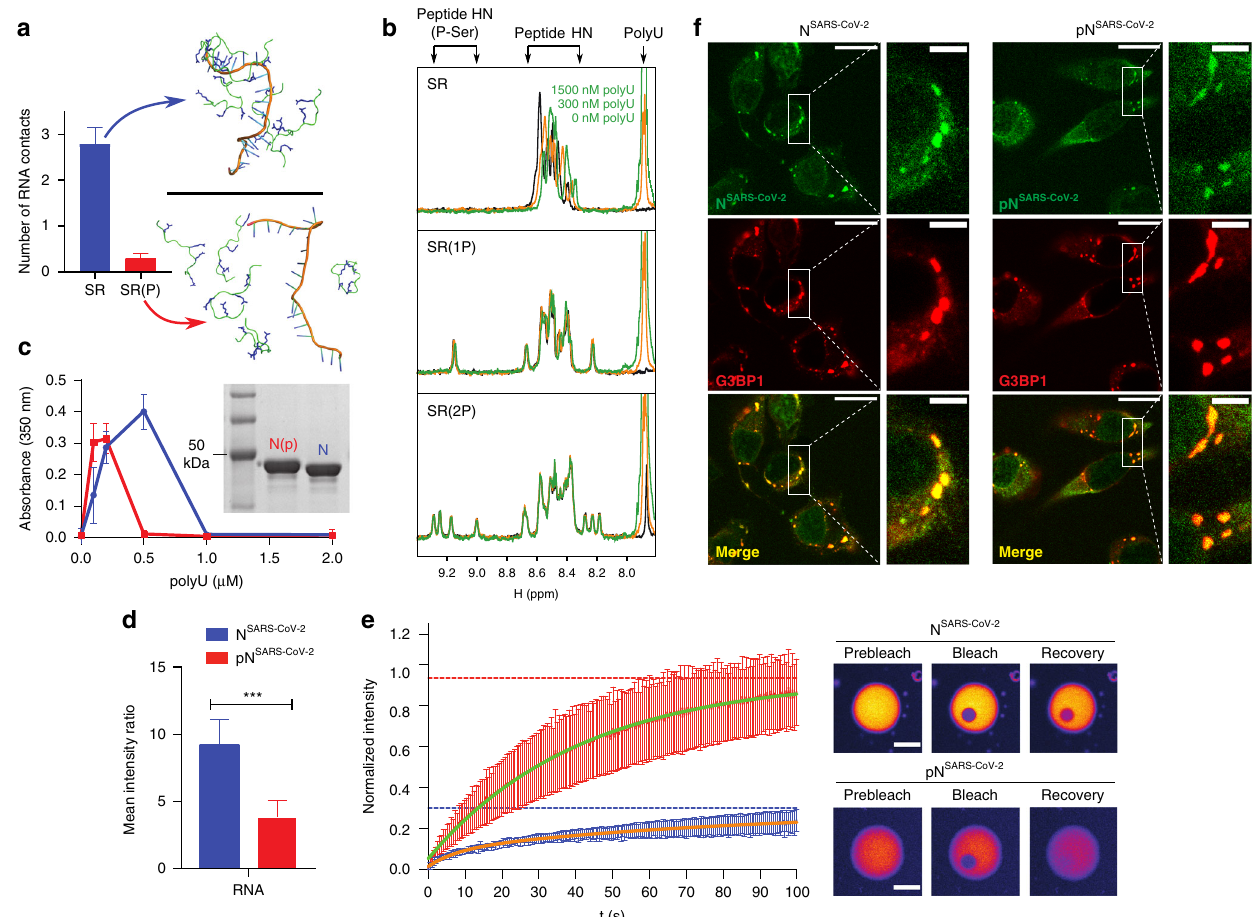
Fig. 4 SR-phosphorylation modulates RNA-induced condensation of the nucleocapsid protein. a MD simulations of SR/polyU-interaction. The number of contacts per peptide with a 20 base length polyU is shown in the top graph for the non-phosphorylated and fully phosphorylated SR-peptide as the average and standard deviation of fi ve independent simulations. Snapshots of both peptides are shown. b 1 H 1D experiments of the SR-peptide (1766.8Da), SPRK1 single-phosphorylated peptide (SR(1 P); 1846.9 Da according to mass spectrometry) and SPRK1 double-phosphorylated peptide (SR(2 P); 1926.9 Da according to mass spectrometry; Supplementary Fig. 8) at three different concentrations of polyU (0, 300 and 1500 nM). The spectral regions, in which the signals of polyU, the backbone H N s of unmodi fi ed residues and phosphorylated serines are located, are marked. The positive charges of the SR-peptide are compensated by the polyU negative charges at around 300 nM. c Turbidity at 350 nm of solutions of non-phosphorylated (blue) and SRPK1- phosphorylated (red) N SARS-CoV-2 in 20 mM NaPi, pH 7.5, at 30 µ M protein concentration and increasing concentrations of polyU. Average values from three independent measurements are shown. Error bars, std. An SDS-Page gel (insert) displays a band shift due to SRPK1-phosphorylation. d Decreased RNA recruitment into polyU-induced droplets of N SARS-CoV-2 upon phosphorylation with SRPK1 kinase. Mean values and standard deviation are displayed (n = 100 droplets). Two-sided t test with P value set to < 0.05 for statistical signi fi cance, *** < 0.001, ** < 0.002 and * < 0.033, ns < 0.12. e FRAP of N SARS-CoV-2 (blue) and SRPK1-phosphorylated N SARS-CoV-2 (red) inside of polyU-induced droplets. Error bars represent the standard deviation for averaged 8 and 10 curves for unmodi fi ed and phosphorylated N SARS-CoV-2 , respectively. Representative micrographs of N SARS-CoV-2 (top) and SRPK1- phosphorylated N SARS-CoV-2 droplets (bottom) before bleaching, after bleaching and at the end of recovery are displayed to the right. Partition coef fi cients of 12.2 ± 2.8 and 4.3 ± 1.2 were calculated for N SARS-CoV-2 and phosphorylated N SARS-CoV-2 , respectively. Scale bars, 10 µ m. f Association of unmodi fi ed (N SARS-CoV-2 , left panels) and phosphorylated (phosphoN SARS-CoV-2 , right panels) nucleocapsid protein of SARS-CoV-2 with stress granules in HeLa cells, micrographs are representative of two independent biological replicates. Scale bar 20 µ m, 5 µ m in